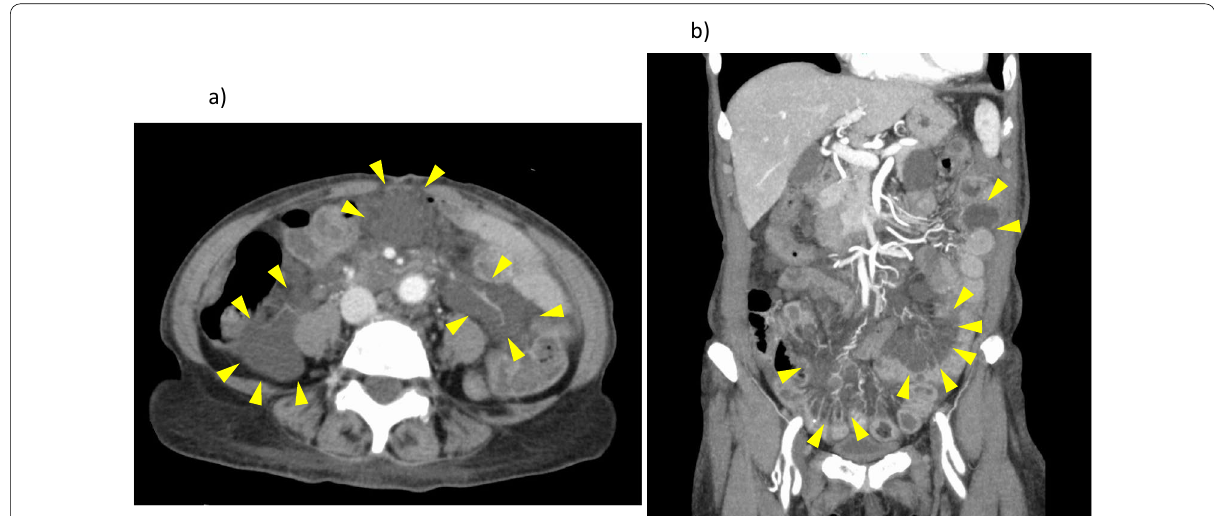
Fig. 1 Enhanced abdominal computed tomography: Multiple low-density areas of mesentery in a axial and b coronal views, devoid of contrast effect (arrowhead)